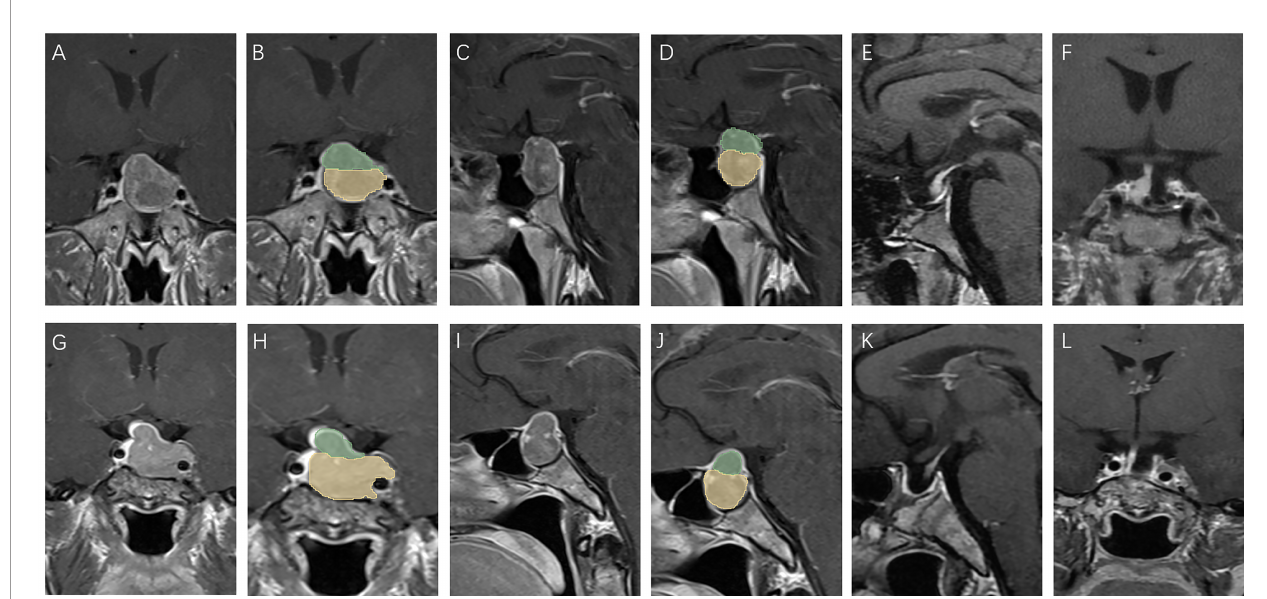
FIGURE 4 | Patients with low V-D value: A 39 year old male, TV: 5781.19 mm 3 , V2: 4376.40 mm 3 , V1:1404.79 mm 3 , V-D: 1.19 (A – D) , no relapse in 7 years of follow-up (E, F) ; a 43 year old female, TV: 5888.45 mm 3 , V2: 5188.17 mm 3 , V1:700.28 mm 3 , V-D: 1.31 (G – J) , no relapse in 7 years of follow-up (K, L)